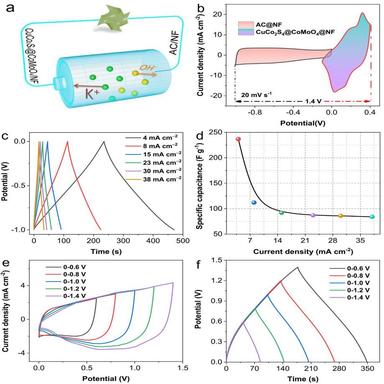
(a) Schematic of the fabricated ASC. (b) CV curves recorded for the carbon black/NF and CuCo2S4@CoMoO4/NF electrodes at 20 mV s1 . (c) GCD curves obtained for the carbon black/NF electrode at different current densities. (d) Specific capacitance versus current density plots obtained for the carbon black/NF electrode. (e) CV at a scan rate of 50 mV s1 and (f) GCD curves obtained for the ASC device in different potential windows.